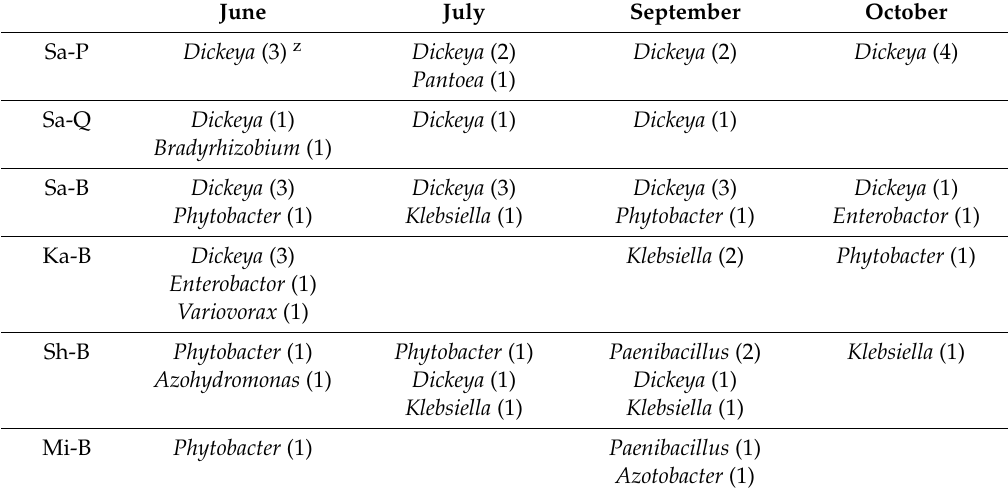
z Figures in parentheses indicate the number of samples in five